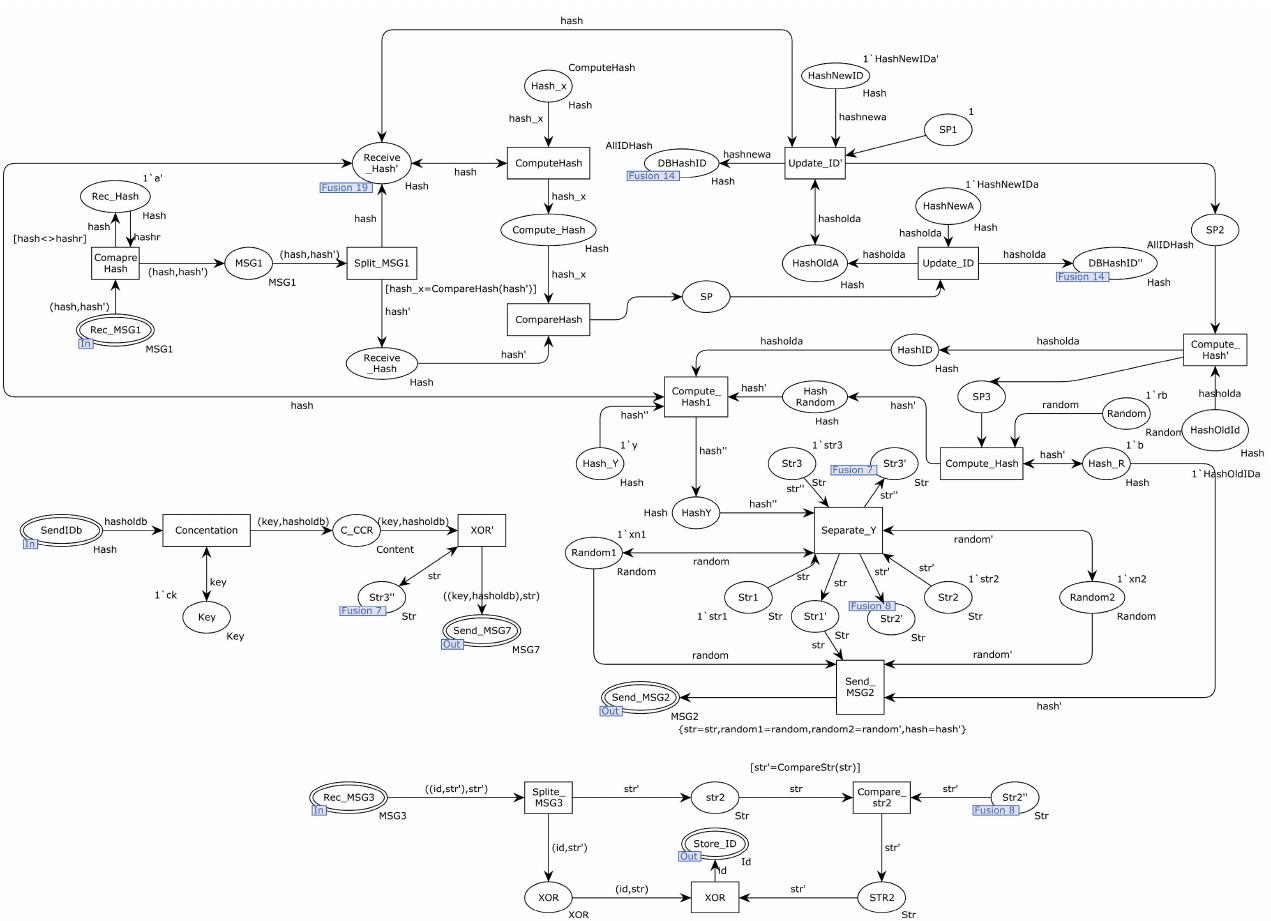
Figure 13. Substitution transition Authentication_A internal